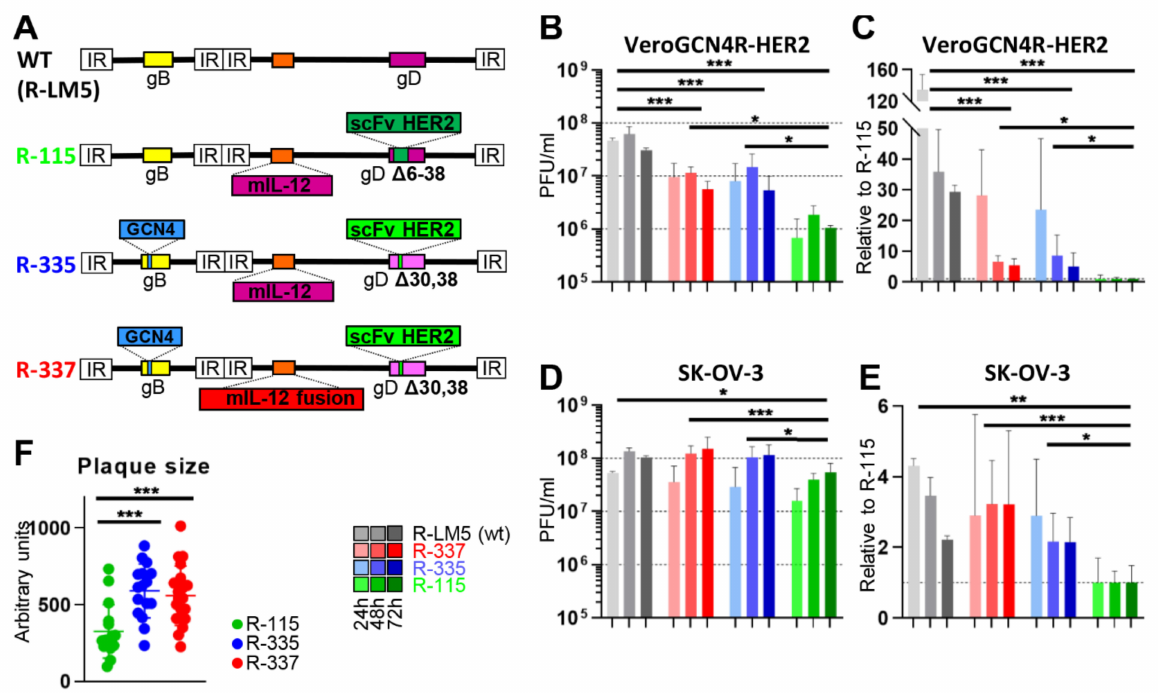
Figure 2. Growth kinetics of 1st and 3rd generation HER2-retargeted oHSVs in cancerous and non-cancerous producer cells. ( A ) Schematic representation of genomes of wt HSV named R-LM5 (carrying GFP), R-115 (1st generation), R-335 and R-337 (3rd generation) retargeted oHSVs. Indicated are the genetic loci of gB, gD, the insertion site of mIL-12 in the US1 and US2 intergenic locus. 1st and 3rd generation recombinant viruses carry the insertion of scFv anti-HER2 for the retargeting to HER2-positive cells, and the deletion of indicated portions of gD for the detargeting from HSV-1 natural receptors HVEM and nectin1. The 3rd generation R-335 and R-337 viruses carry the GCN4 peptide in gB between aa 81 and 82, and were engineered as detailed in [17,54]. ( B – E ) Yields of the wt HSV named R-LM5 (carrying GFP), R-115, R-335 and R-337 in VERO-GCN4R-HER2 ( B , C ) and in SK-OV-3 ( D , E ) cells at 24, 48 and 72 h after infection. Replicate cultures of each cell line were infected with the indicated viruses at 0.1 PFU/cell as titrated in SK-OV-3 cell line. Progeny virus was titrated in SK-OV-3 cells. In panels C and E, yields are expressed relative to that of R-115. The data represent the average of at least five independent experiments ± SD. ( F ) Plaque size of the indicated viruses five days after infection. For each virus-infected culture 20 plaque pictures were taken, expressed as arbitrary units and plotted ± SD. ( B – F ) Statistical significance was calculated by One Way ANOVA test and expressed as * = p -value < 0.05; ** = p -value < 0.01; *** = p -value <